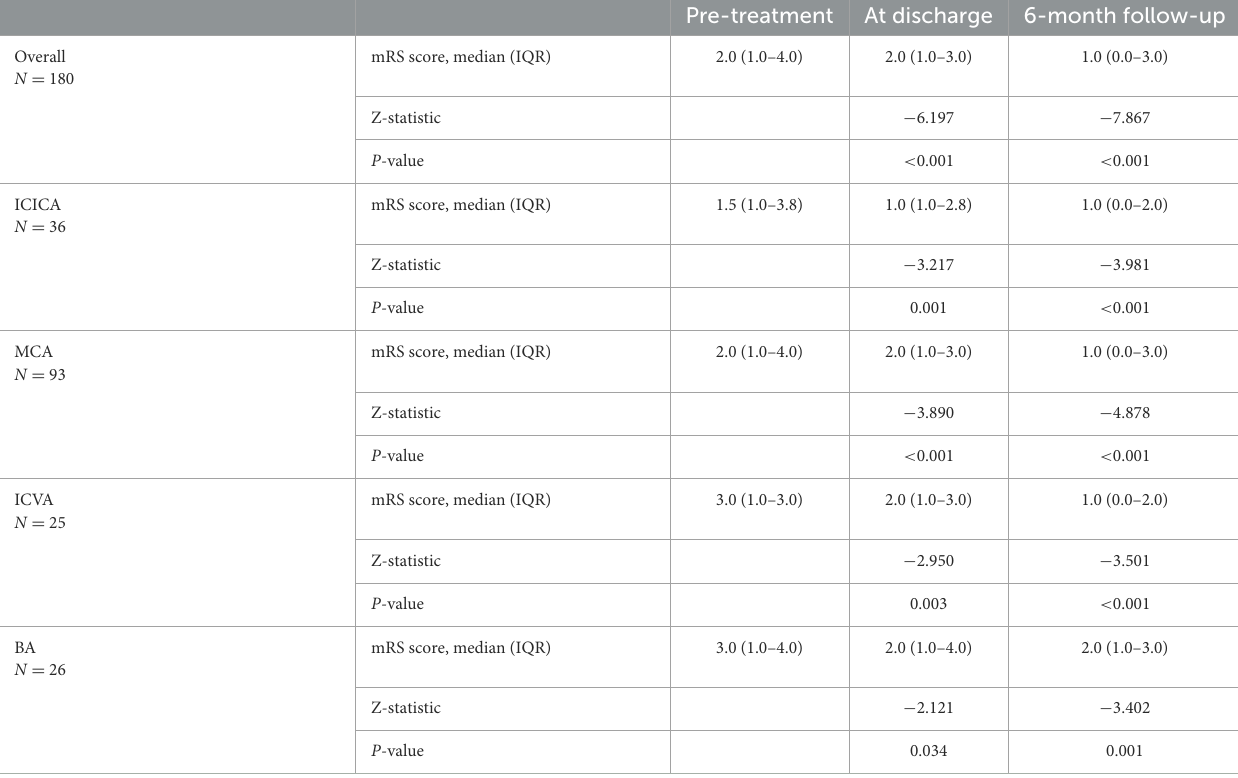
TABLE 4 Comparative analysis of mRS scores at different stages of successfully treated patients.